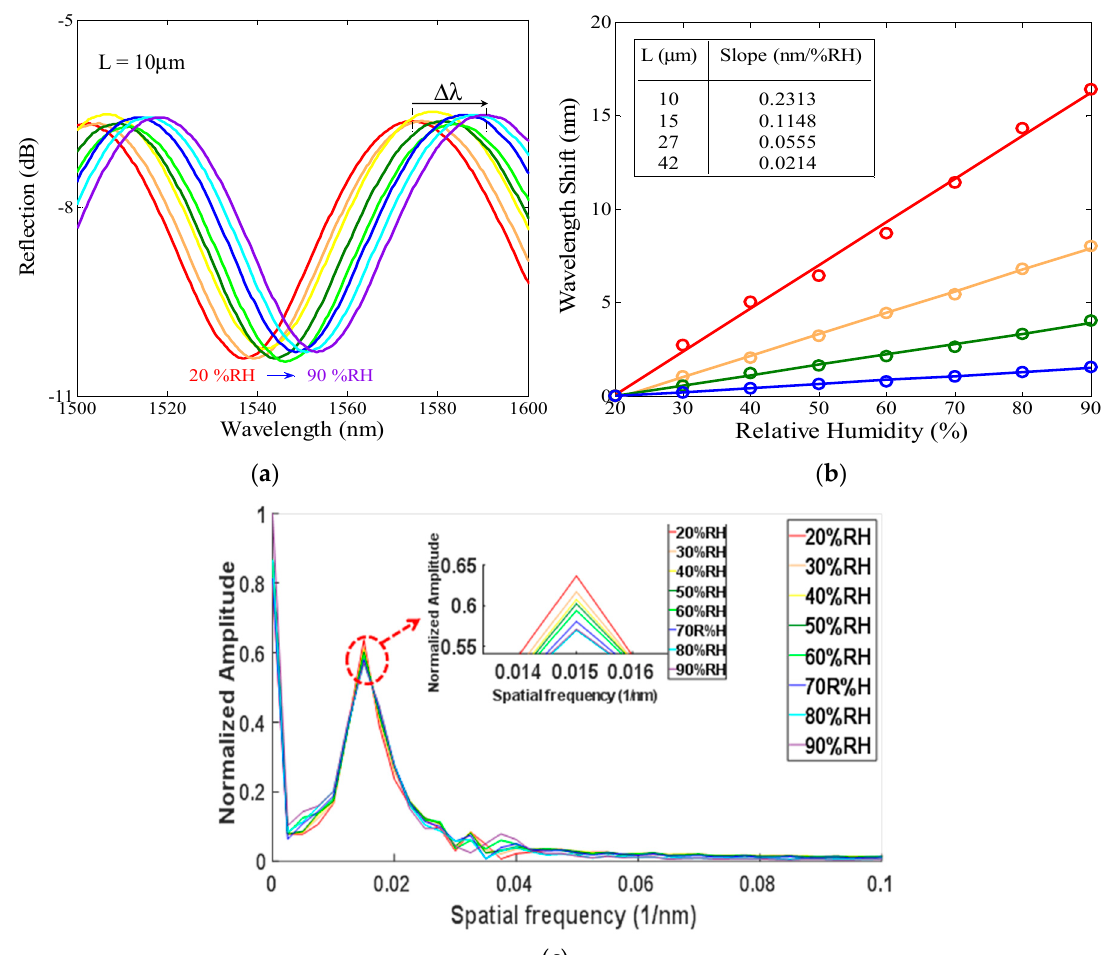
Figure 4. ( a ) Interference spectra of the PMCFFI (L = 10 μ m) with only relative humidity (RH) variations; ( b ) Sensitivity comparison of different L based on wavelength shift due to RH changes; ( c ) the FFT result of the PMCFFI (L = 10 μ m) with only RH variations (from 20% to 90%).